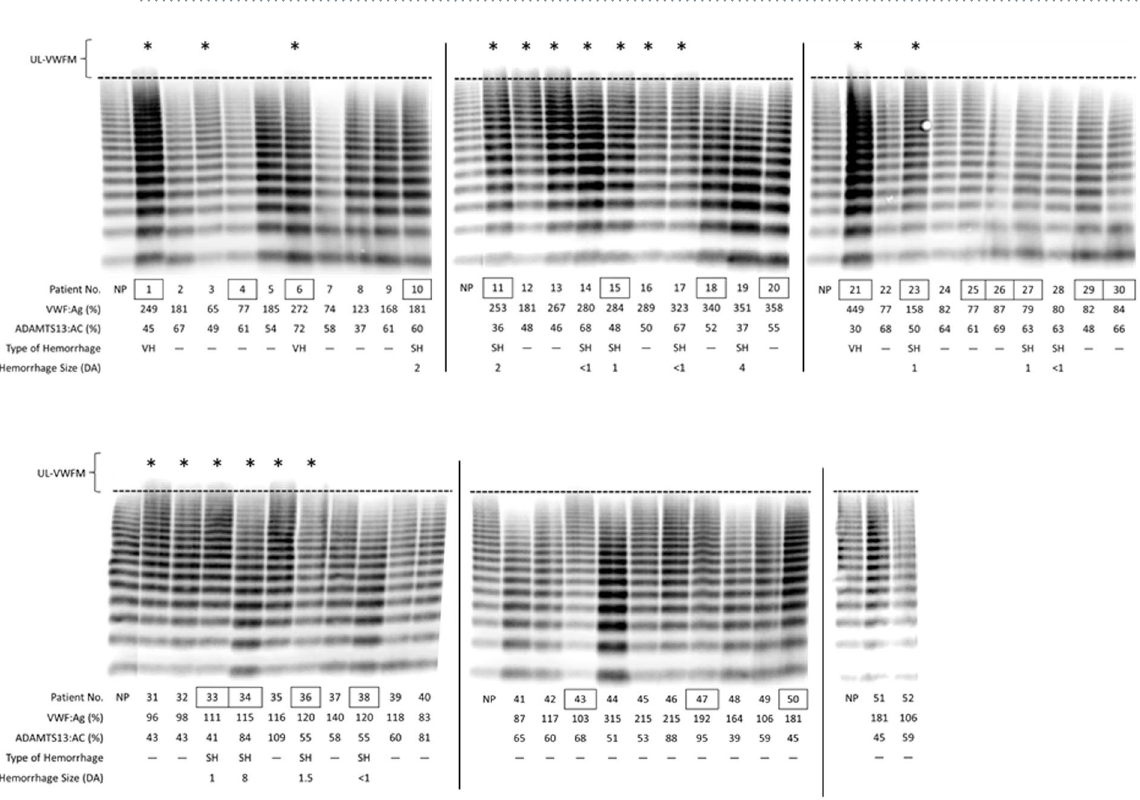
Figure 2. VWF multimer analysis in patients with untreated exudative AMD. Fifty-two out of 114 patients with untreated exudative AMD, patient number (Nos.) 1–52, were shown in this figure. Each patient number enclosed by a square indicates a patient with polypoidal choroidal vasculopathy (PCV). UL-VWFMs were found in 18 patients with AMD, including 9 patients with PCV and 9 with typical AMD. Of these, 3 patients (Nos. 1, 6, and 21) had vitreous hemorrhage (VH) and 6 (Nos. 11, 15, 23, 33, 34, and 36) had subretinal hemorrhage (SH) ≥ 1 disc area (DA). Asterisks indicate UL-VWFM positivity. NP: normal pool